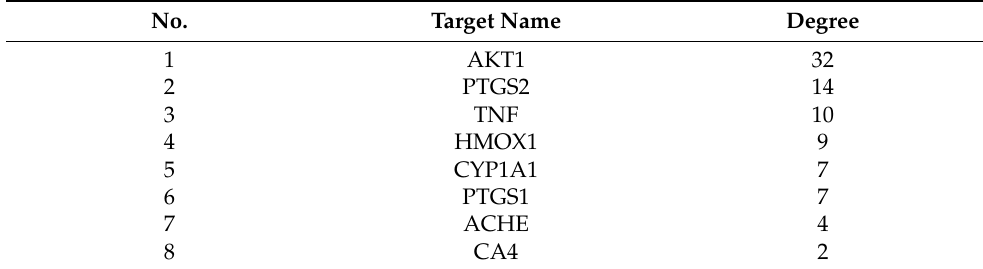
Table 5. The degree value of the intersection target.